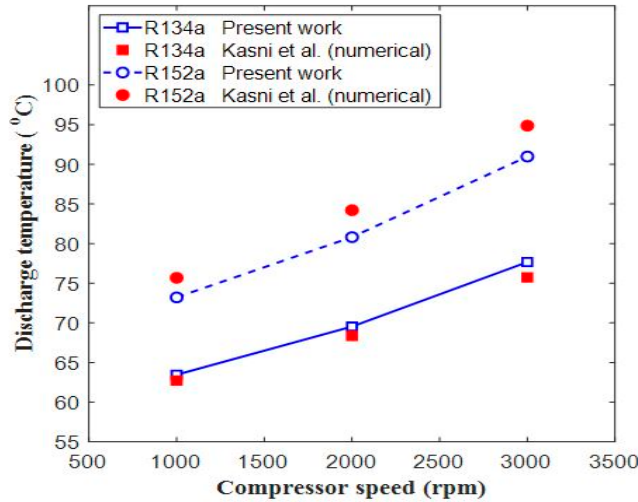
Figure 7 . Comparison of discharge temperature vs. compressor speed [9] .